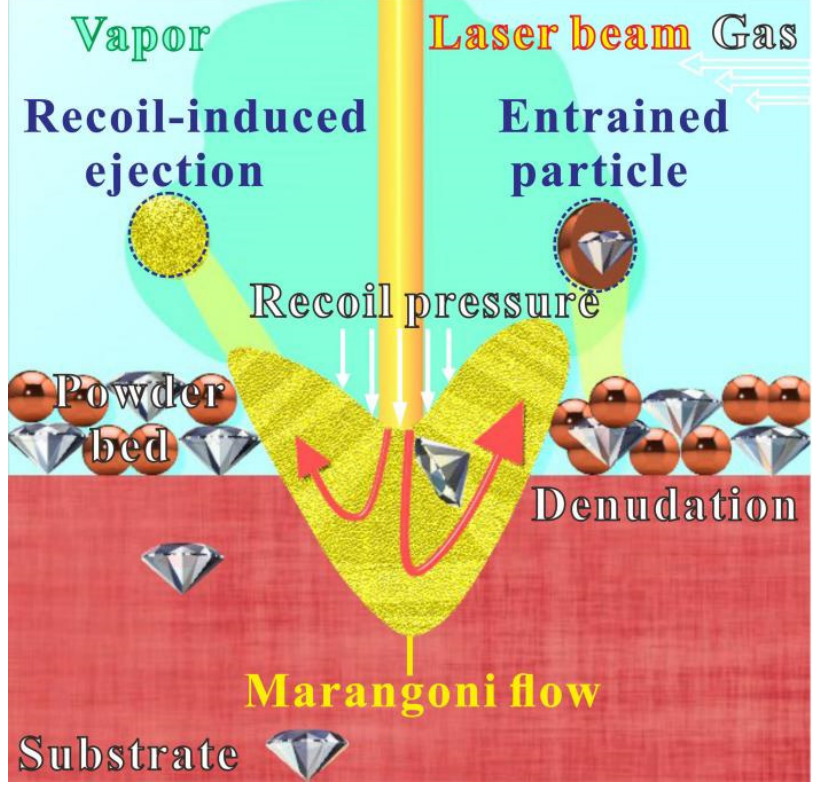
Figure 4. Spatter ejection phenomenon in SLM of the coated diamond/copper combined materials.